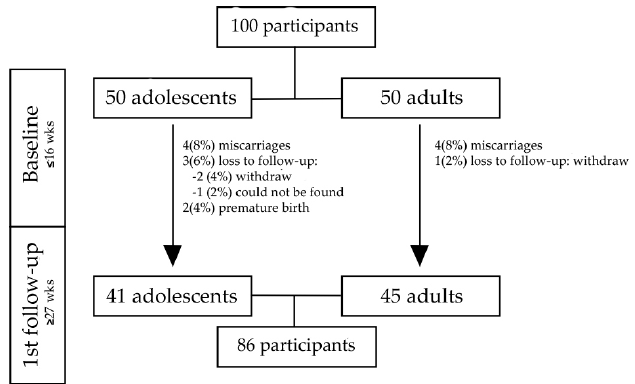
Figure 1. Flowchart of sample by age group within the Adolescent and Motherhood Research (AMOR) study in the Trairi region, Rio Grande do Norte, Brazil, 2017–2018.